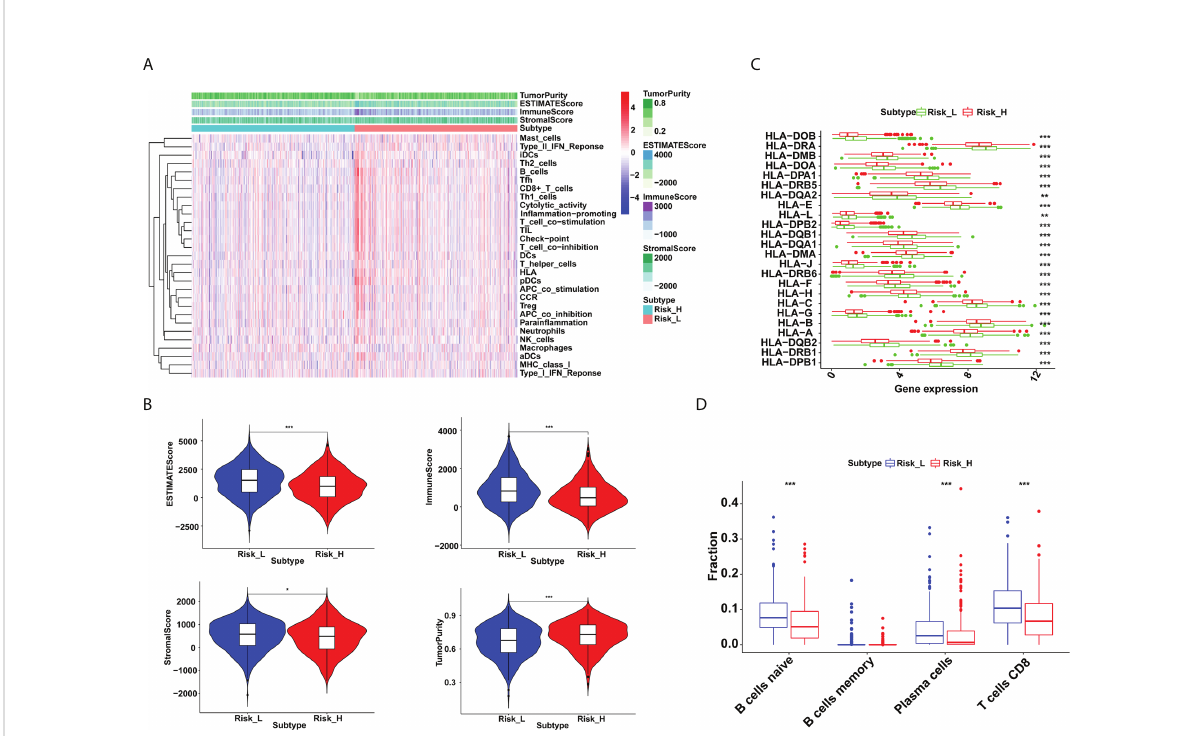
FIGURE 3 Immune microenvironment differences between low- and high-risk groups in breast cancer. (A) The distribution of immunocytes in the high- and low-risk groups. (B) Higher immune, stromal, and ESTIMATE scores, and lower tumor purity were exhibited in the low-risk group (* P < 0.05 and *** P < 0.001). (C) The HLA-related genes ’ expressions were upregulated in the low-risk group (** P < 0.01 and *** P < 0.001). (D) Proportion of naive B cells, plasma cells and CD8 + T cells were increased in the low-risk group (*** P <